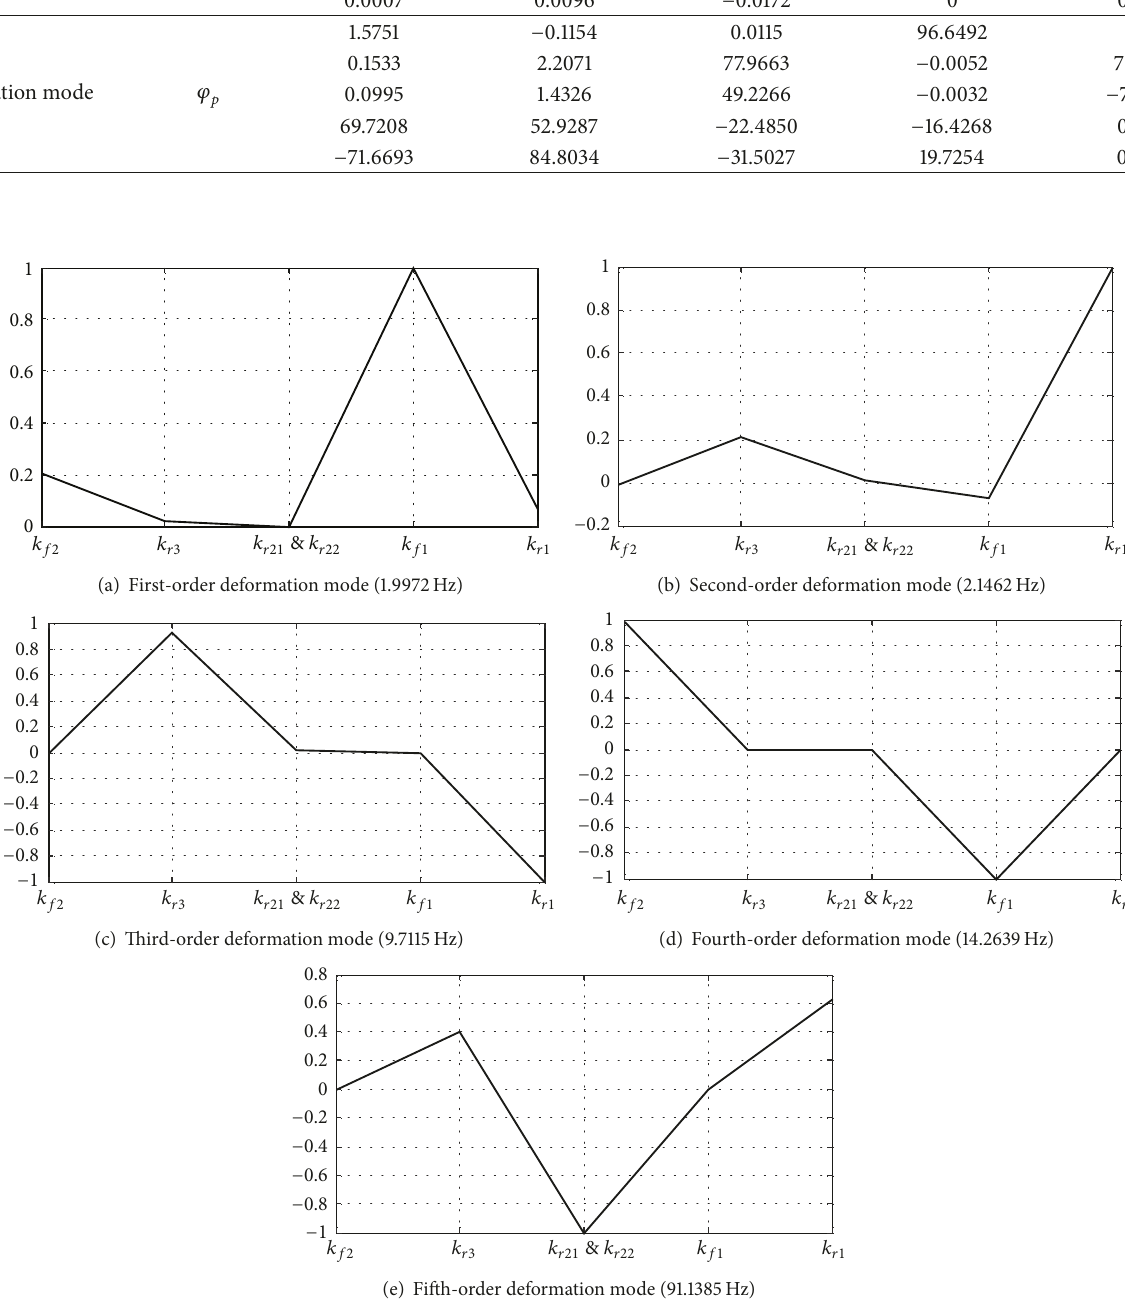
Figure 5: Vibration mode diagram of the